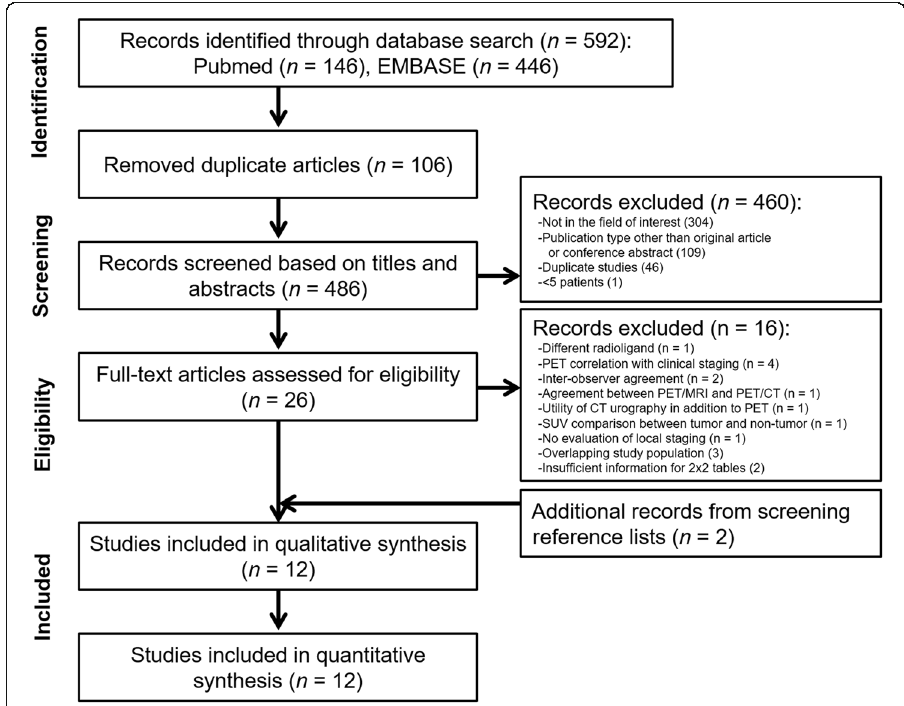
Fig. 1 Flow diagram for study selection